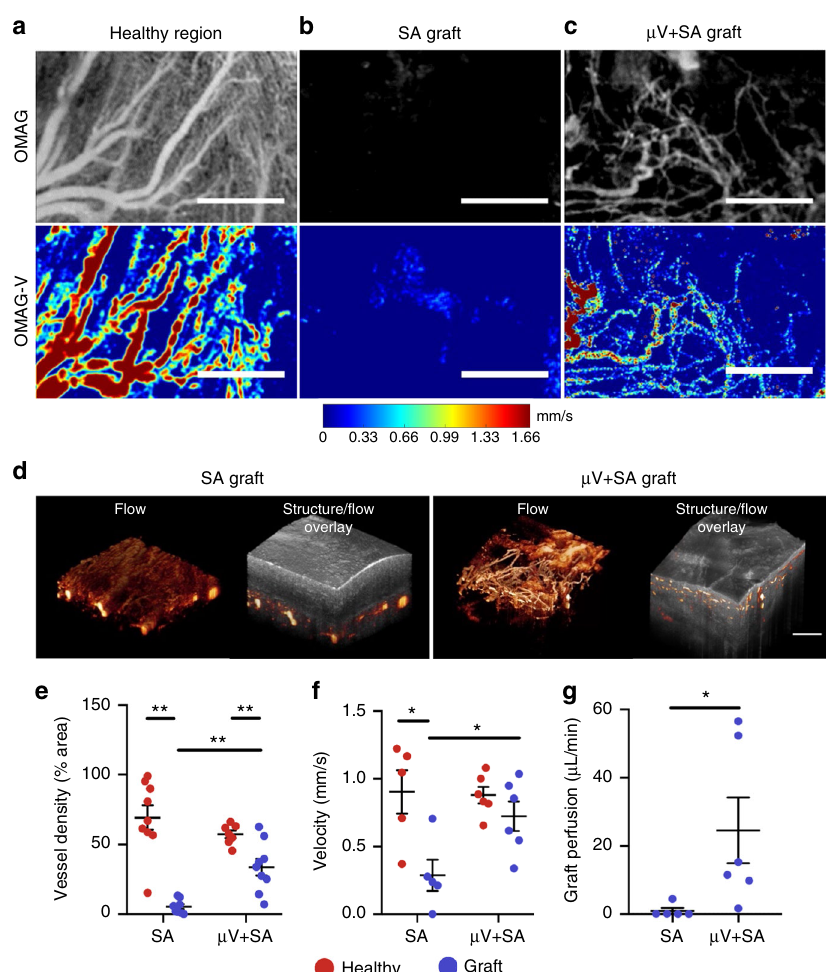
Fig. 5 Implanted vascular constructs in infarcted rat heart model with optical microangiography (OMAG) assessment of real-time perfusion 5 days post- implantation. a – c Doppler-based images of vascular fl ow in Langendorff perfused engrafted hearts for a healthy region, b control graft (self-assembled (SA)), and c patterned, perfusable graft ( μ V + SA). Top panels, high-resolution, non-quantitative OMAG images. Bottom panels, OMAG-V images with linear correlation between intensity and velocity. Scale bar, 500 μ m. d Three-dimensional views of OMAG fl ow data and overlay of OMAG structure and fl ow data for SA graft and μ V + SA graft. Scale bar, 500 μ m. e Quantitation of vessel density of perfused vessels in healthy (red circles) and graft (purple circles) regions for SA and μ V + SA. N = 9 and 8 biologically independent animals for SA and μ V + SA, respectively. p = 0.0009 for SA healthy and graft, p = 0.0016 for μ V + SA healthy and graft, p = 0.0012 for SA and μ V + SA graft, p > 0.05 for all others (two-tailed t test). f Velocimetry measurements of blood fl ow velocity in small arterioles (diameter between 20 and 40 μ m) of healthy and graft regions. N = 5 and 6 biologically independent animals for SA and μ V + SA, respectively. p = 0.016 for SA healthy and graft, p = 0.023 for SA and μ V + SA graft, p > 0.05 for all others (two-tailed t test). g Volumetric perfusion rate in SA and μ V + SA grafts from velocimetry data. N = 5 and 6 biologically independent animals for SA and μ V + SA, respectively. p = 0.038 for SA and μ V + SA graft (two-tailed t test). Representative images for a – d from 5 biologically independent animals containing SA grafts, 6 biologically independent animals containing μ V + SA grafts, and 11 corresponding healthy regions from all animals containing grafts, with similar results. Error bars, mean ± SEM. * p < 0.05, ** p < 0.01 determined using two-tailed t (healthy region of SA), 113.9 ± 16.9 µL/min (healthy region of µV perfused vessels (of both rat and human origin), while an anti- + SA)). These results demonstrate that engineered vascular con- rhodamine antibody was used to speci fi cally detect UEA I + structs integrate functionally with the host vasculature and that perfused human vessels within the graft. Antibodies against pre-patterned, perfusable vasculature improves graft perfusion dynamics. Supplementary Figure 10A). The presence of human vessels was con fi rmed with additional staining for human endothelial junc- tion protein, hCD31 (Supplementary Figure 10B-D). Quanti fi -